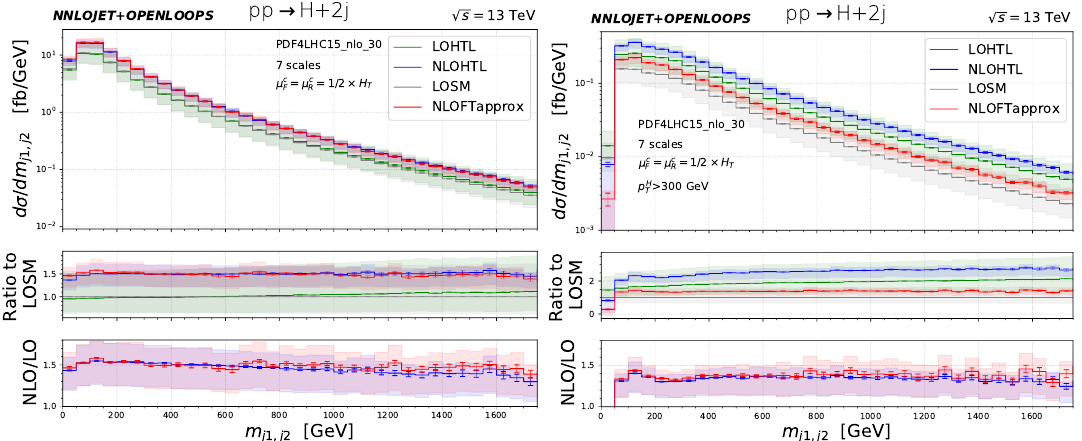
Figure 6 . Invariant mass distribution of the di-jet system in H + 2 jets production. Colour coding and labelling as in figure